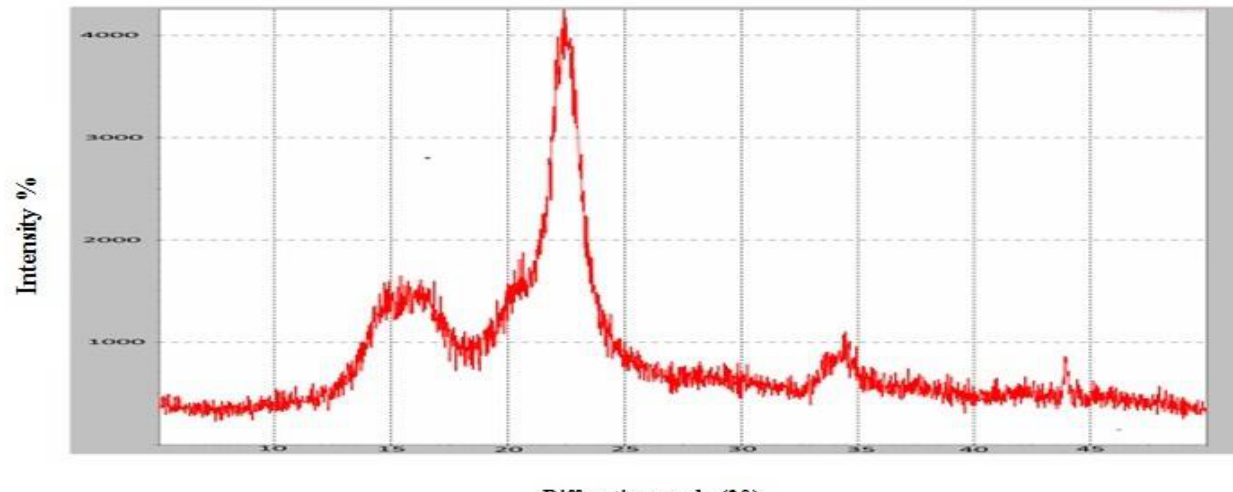
Figure 12.X-Ray diffraction of liquisolid system LS-2